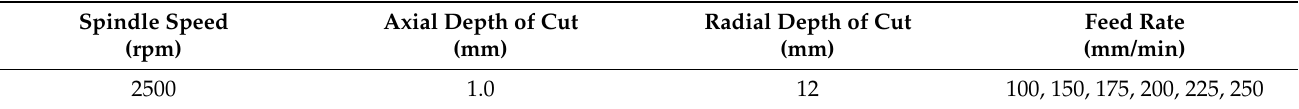
Table 1. Cutting parameters for cutting force coefficients.